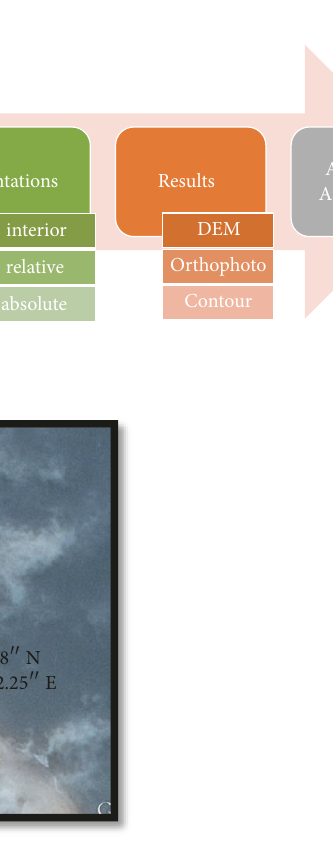
Figure 3: Four coordinates at study area.